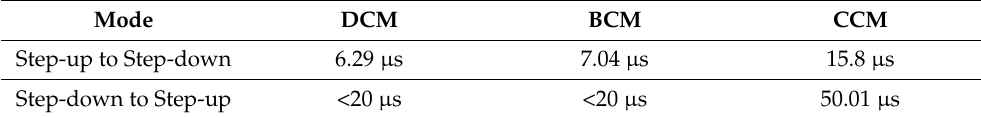
Table 3. Comparisons of transition time.